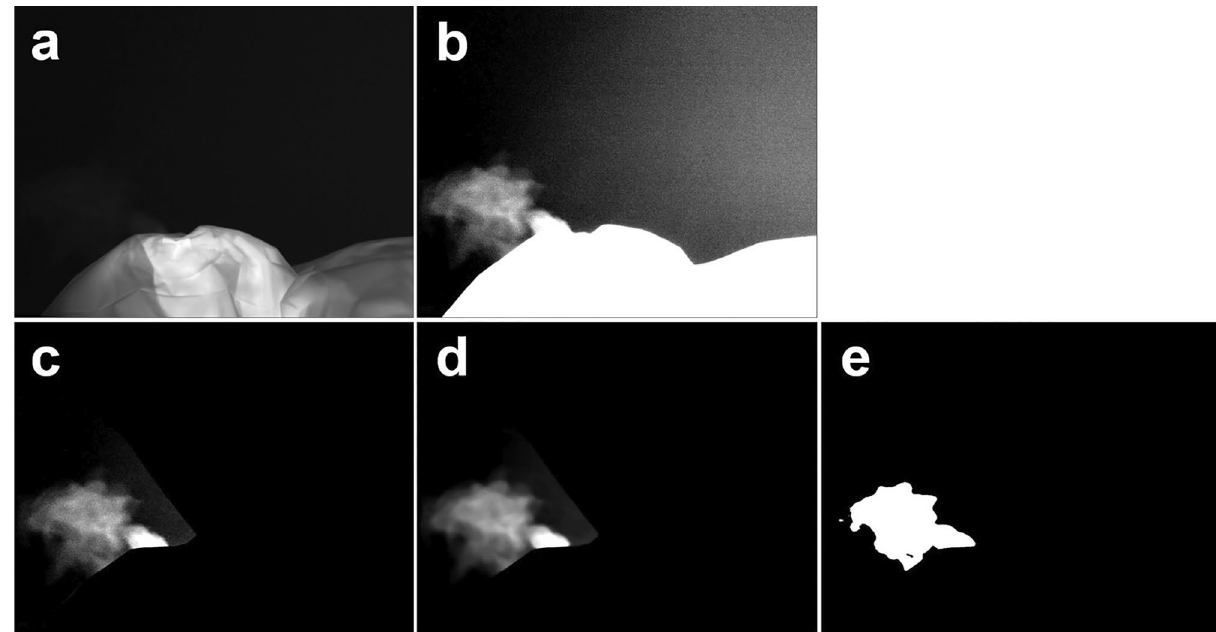
Figure 3. Five steps involved in image processing. ( a ) Unprocessed image. ( b ) Image with dynamic range and contrast adjusted for airflow. ( c ) Image with masked non-airflow areas. ( d ) Image with noise reduction and smoothing. ( e ) Binarized